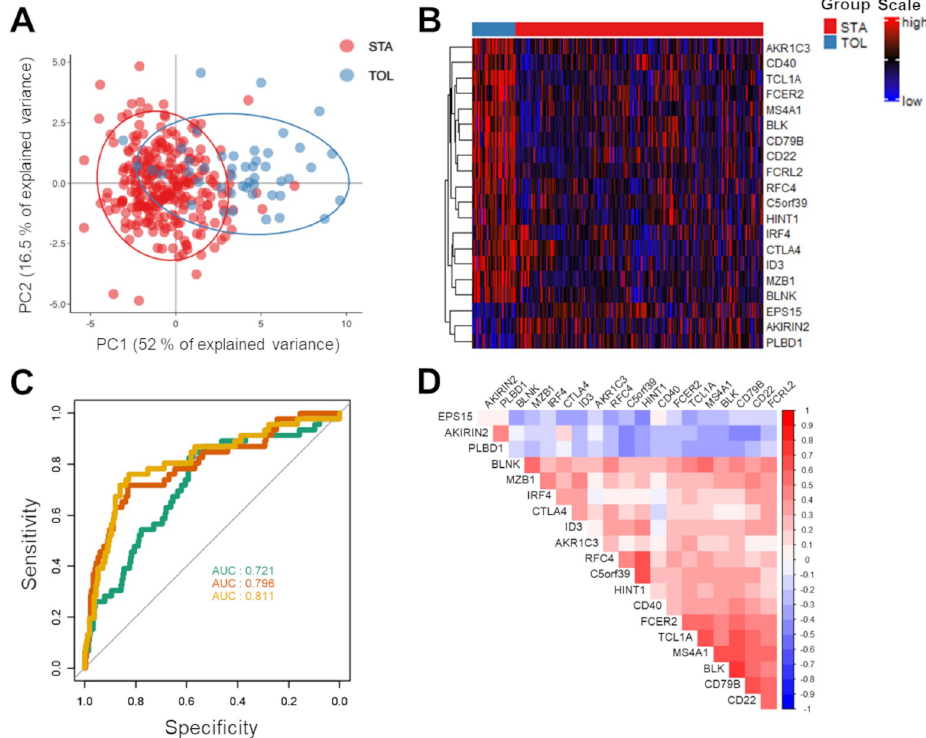
Fig 2. Data analysis of a 20-gene expression dataset from renal transplant patients. A) PCA and B) heatmap plots highlighting the clear difference in gene expression between the two groups, TOL (blue) and STA (red). C) ROC curves of groups displaying the AUCs of the selected genes, AKR1C3 , AKIRIN2 and CD22 . D) Gene-gene correlation analysis using a correlogram to highlight groups of genes.